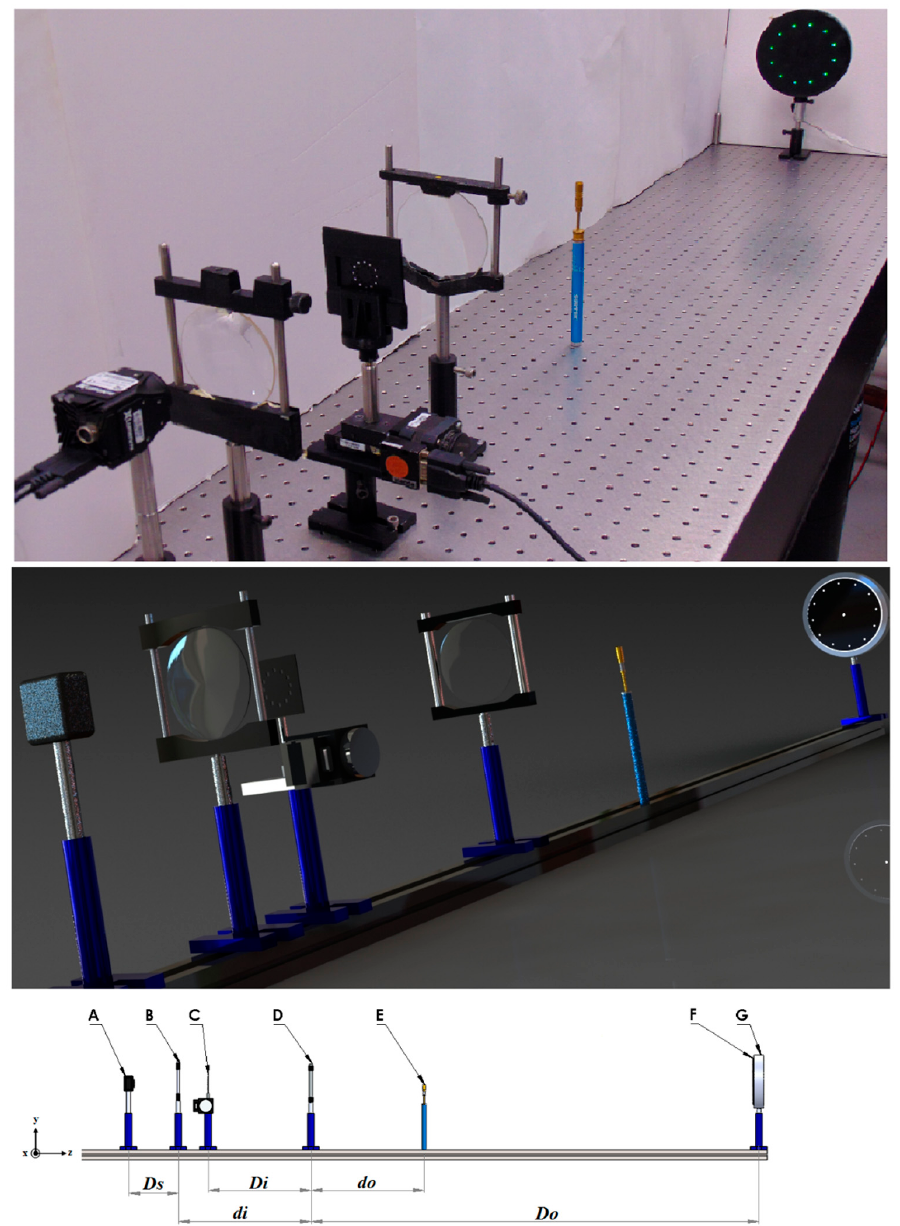
Figure 1. Scheme and picture of a focusing schlieren system based on an off-axis circular illumination.